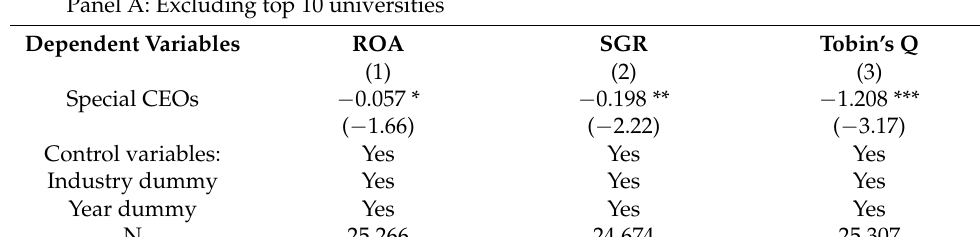
Table 6. Instrumental variable regression (GMM) (sub-samples). Panel A: Excluding top 10